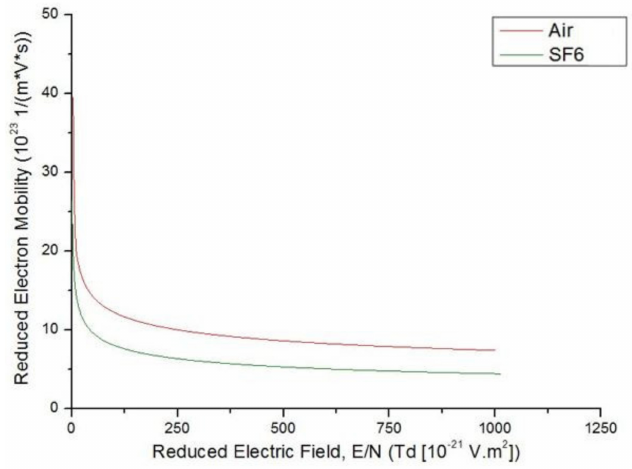
Figure 2. Reduced Electron Mobility as a function of Reduced Electric Field (E/N) for SF 6 [24] and air [26].